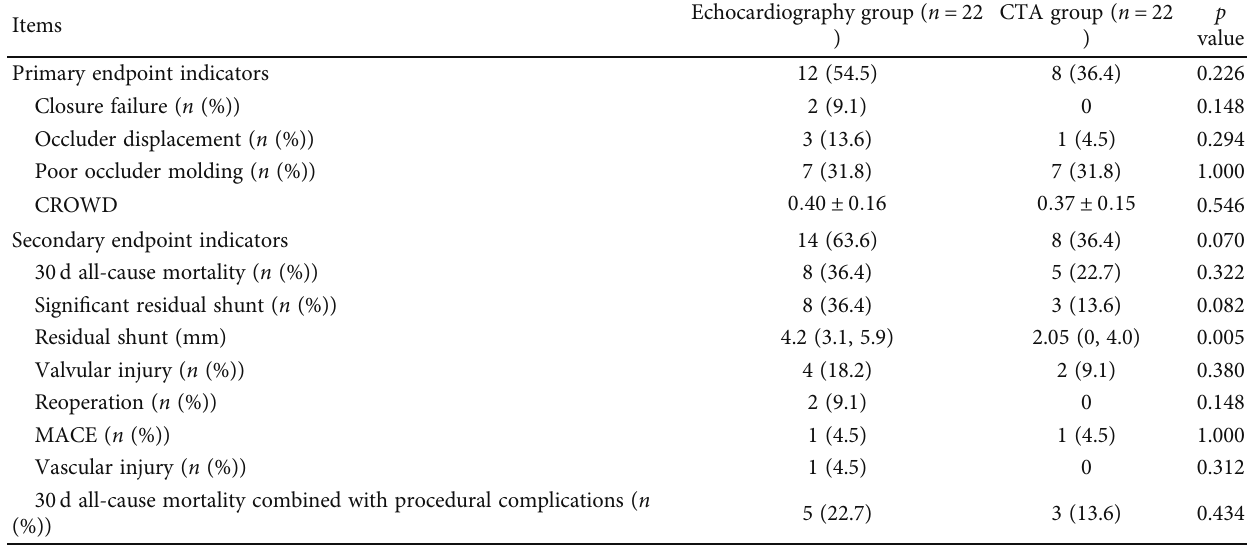
Table 3: Comparison of endpoint indicators between the echocardiography group and CTA